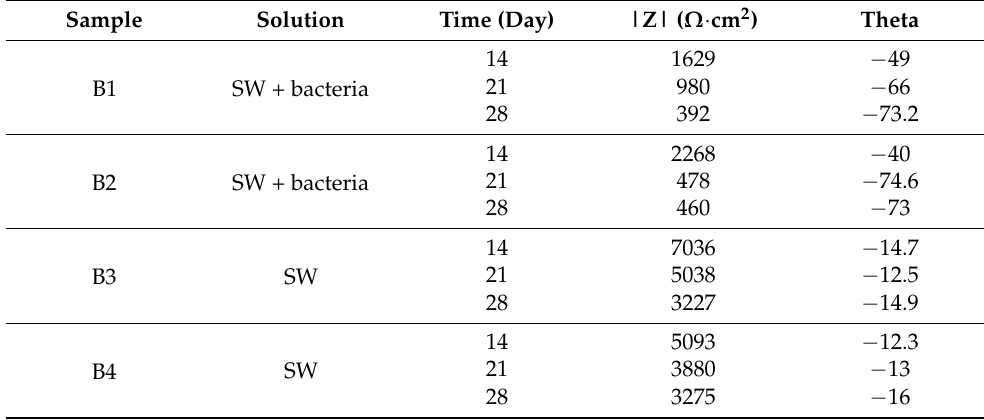
Table 5. Impedance values and phase angles at 0.01